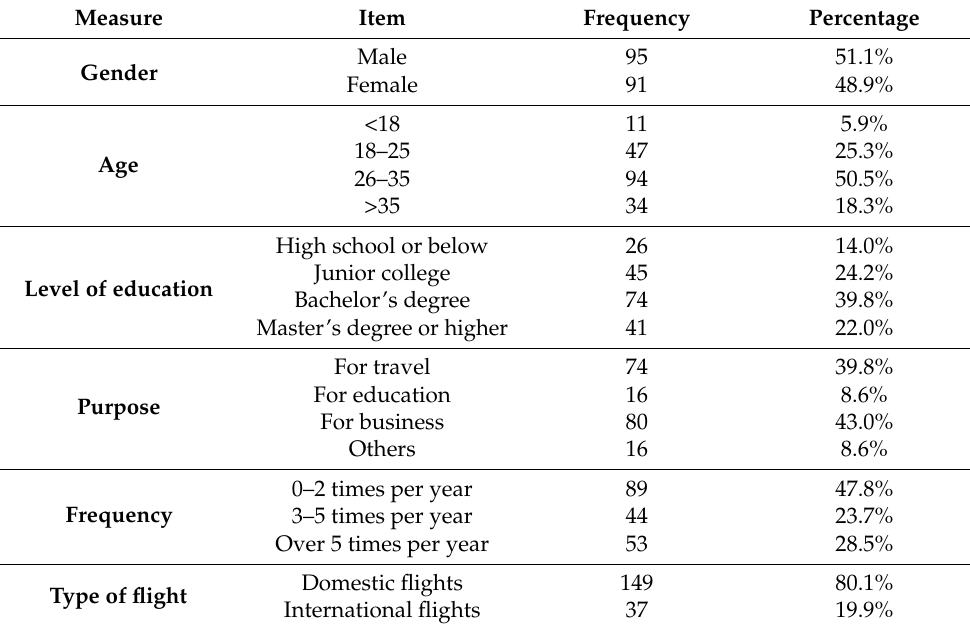
Table 1. Characteristics of